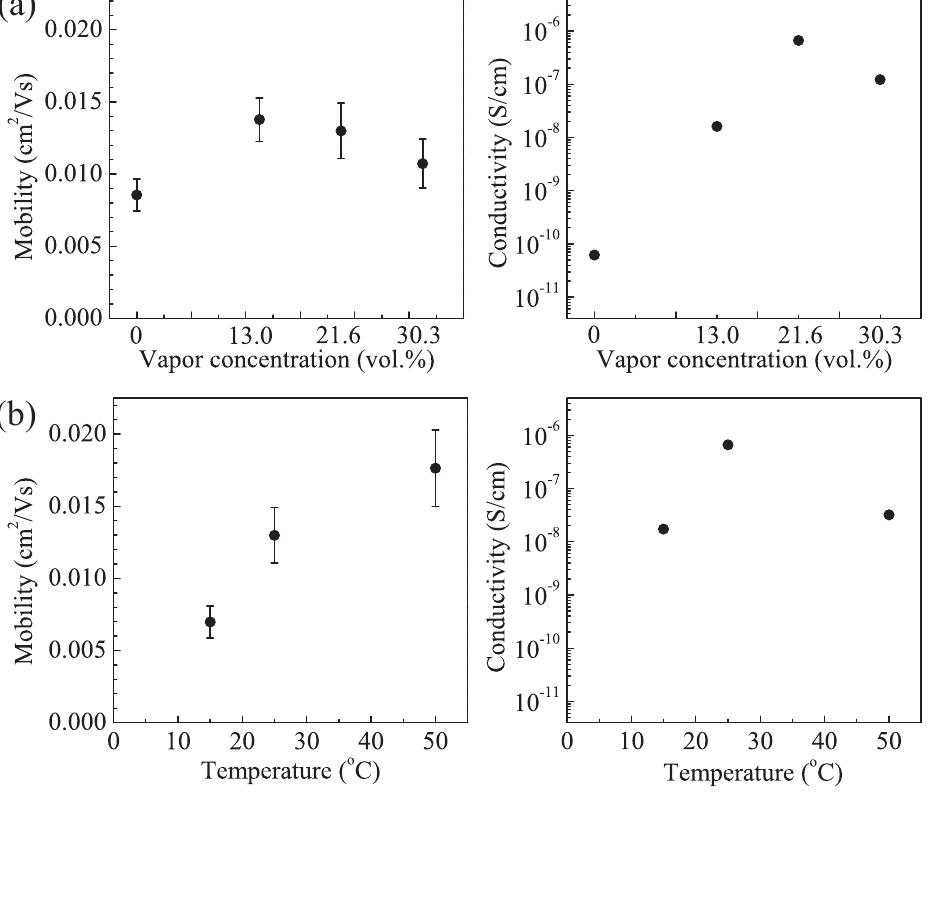
Figure 3. Hole mobility and conductivity of the PAT6 film depending on ( a ) concentrations at a temperature of 25 °C, and ( b ) temperature at 21.6 vol % vapor concentration in the SVT.